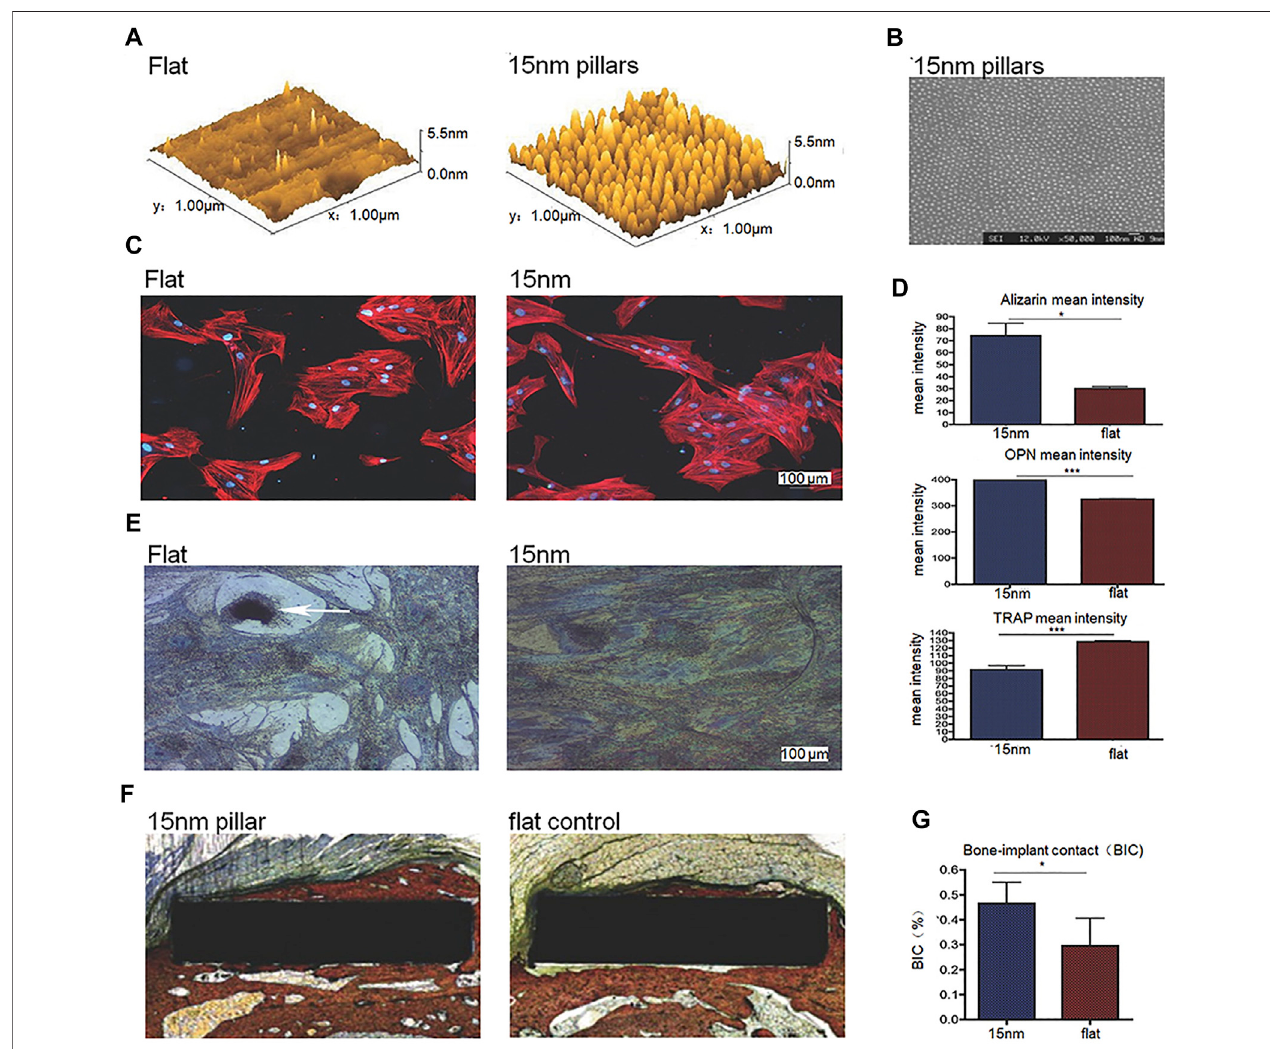
FIGURE 2 | (A,B) 3D Atomic Force Microscope (AFM) height images and SEM image of disordered 15 nm nanotube arrays on the titanium surface processed through anodization. (C) Immuno fl uorescent images of cells on surfaces in different groups. (D) Mean intensity of alizarin, osteopontin (OPN) and tartrate resistant acid phosphatase (TRAP, indicating osteoclastic activity of the cells) of cells on surfaces in different groups. (E) TRAP histochemical images of cells on surfaces in different groups. (F,G) Histological staining images and quantitative results of bone-implant contact (BIC). Reprinted with permission from (Silverwood et al., 2016).